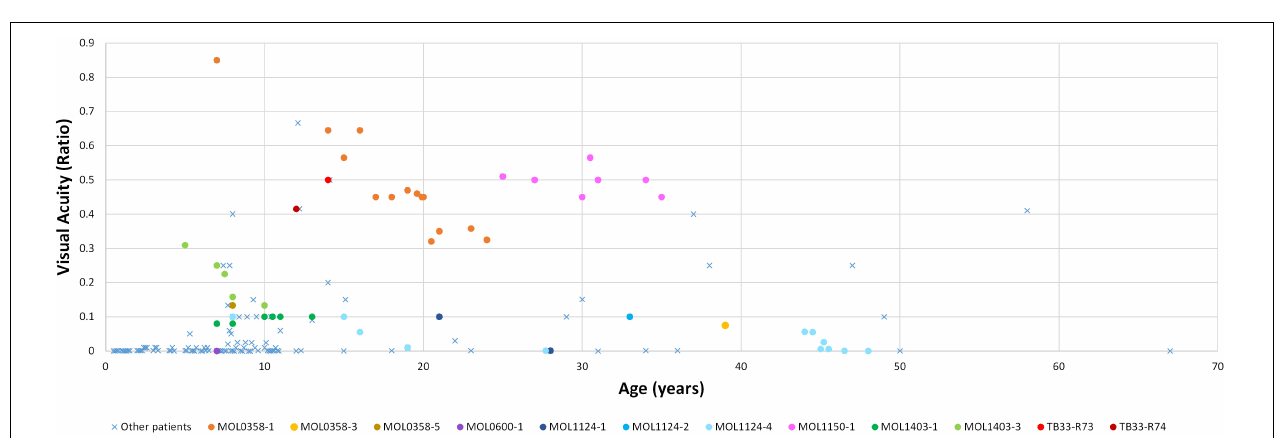
FIGURE 2 | Best corrected visual acuity measurements (presented as Snellen ratio) versus age. Measurements of RPGRIP1 patients previously reported in the literature are denoted by a blue X. The earliest available measurement for each such patient was taken. BCVA measurements of patients from our cohort are presented as circles, with each color representing a different patient. In this group, all available VA measurements along time are shown.